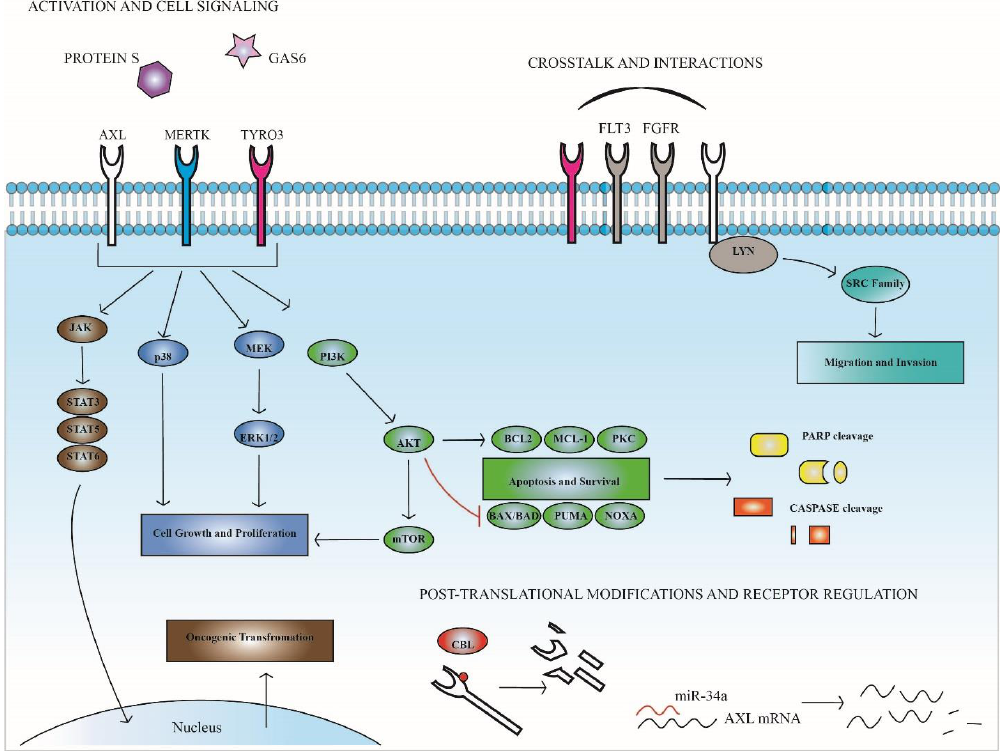
Figure 2. TAM signaling, regulation, and protein interactions in leukemia. TAM receptors signal through pro-survival and anti-apoptotic pathways and also have roles in migration and invasion. Key downstream signaling proteins and their oncogenic functions are depicted above. Specific proteins and response patterns are leukemia subtype dependent. Regulation of AXL by the E3-ligase CBL and miR-34a are also depicted. AXL physically interacts with the proteins FLT3, FGFR, TYRO3 and LYN. The consequences of these interactions are